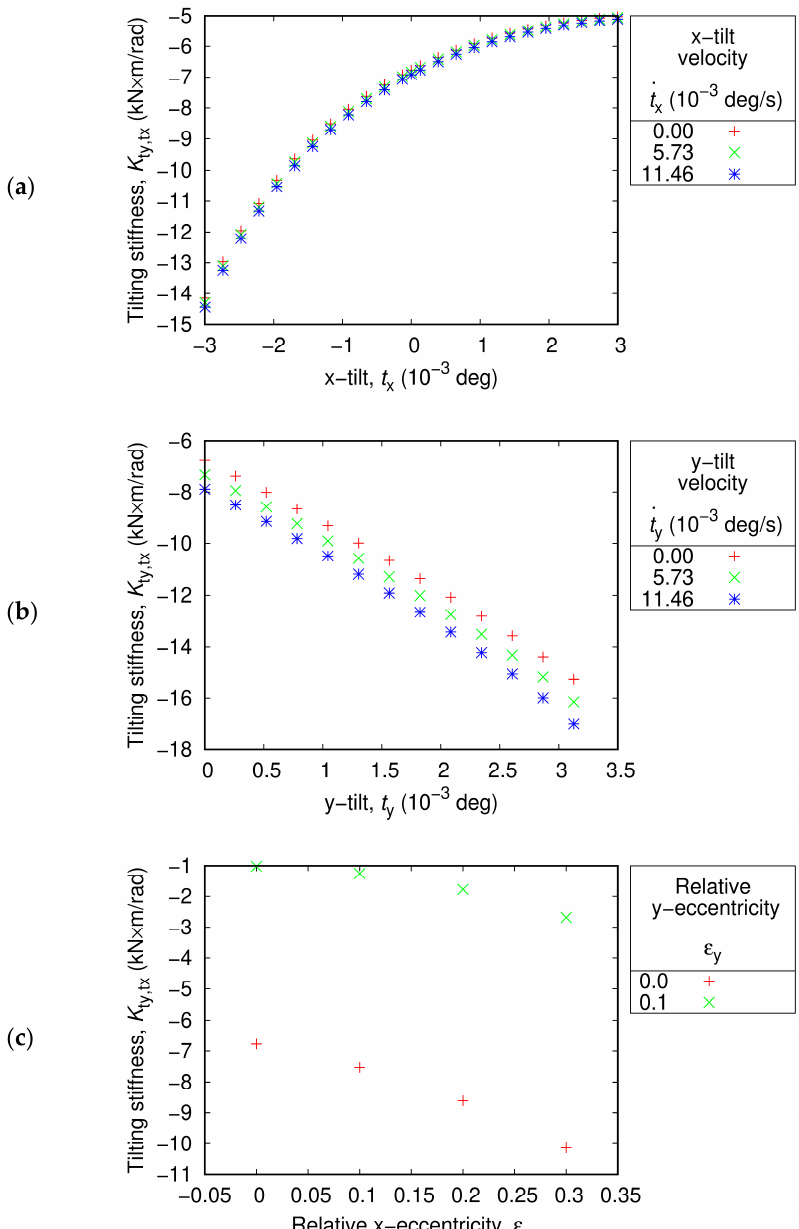
Figure 6. Parameter sensitivity of the cross-coupled stiffness coefficient K ty , tx : ( a ) Effects of the tilting angle and tilting velocity in the x-direction; ( b ) Effects of the tilting angle and tilting velocity in the y-direction; ( c ) Effects of relative eccentricities. All unreferenced parameters have zero values. The direct stiffness coefficient K ty , ty is higher than that of K tx , tx . K ty , ty falls in the range